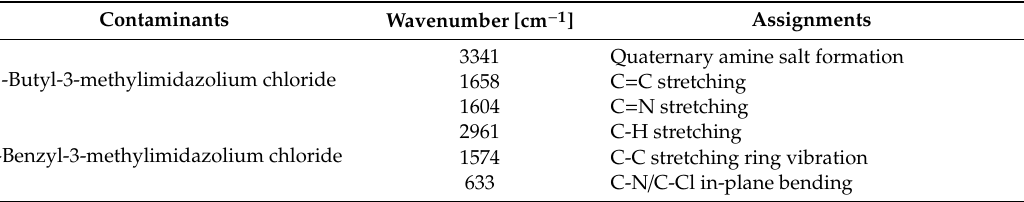
Table 4. FTIR band assignments of ionic liquids, enzymes, and biomass-derived chemicals on poplar [49–65].